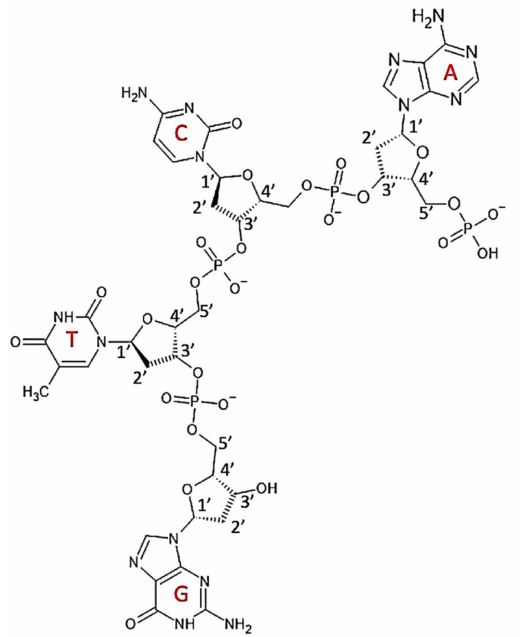
Figure 8. Single-strand DNA fragment drawn using ACD/ChemSketch. Red letter represents a nitrogenous base: A—adenine, C—cytosine, T—thymine, and G—guanine.